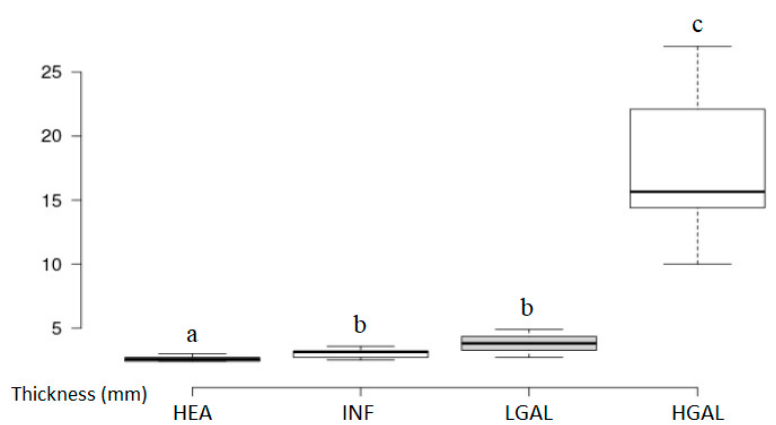
Figure 4. Box and whisker plot of the gastric wall thickness for healthy (HEA), inflammatory (INF), low-grade alimentary lymphoma (LGAL) and high-grade alimentary lymphoma (HGAL). a,b,c Values with different superscript letters differ significantly ( p < 0.001). Table 1. Wall thickness B-mode evaluation for healthy (HEA), inflammatory (INF), low-grade alimentary lymphoma (LGAL) and high-grade alimentary lymphoma (HGAL) reported as means with standard deviations (±SD).